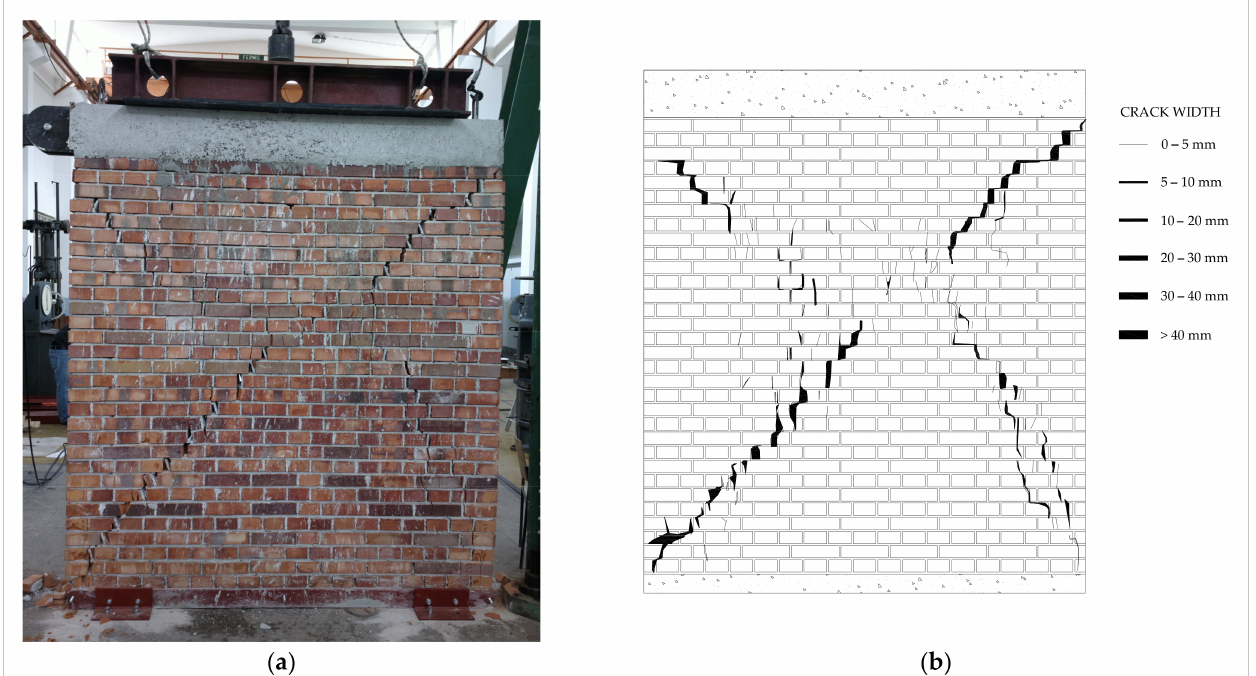
Figure 10. Wall W1 after testing: ( a ) photograph; ( b ) crack pattern and crack width.